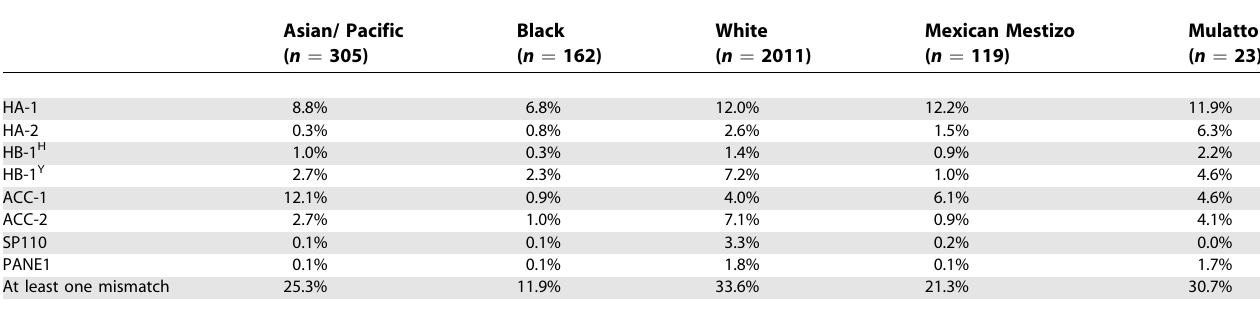
Table 6. Estimated Disparity Rates for Hematopoietic Minor H Antigens in MUD Transplant Pairs Corrected for the Frequencies of